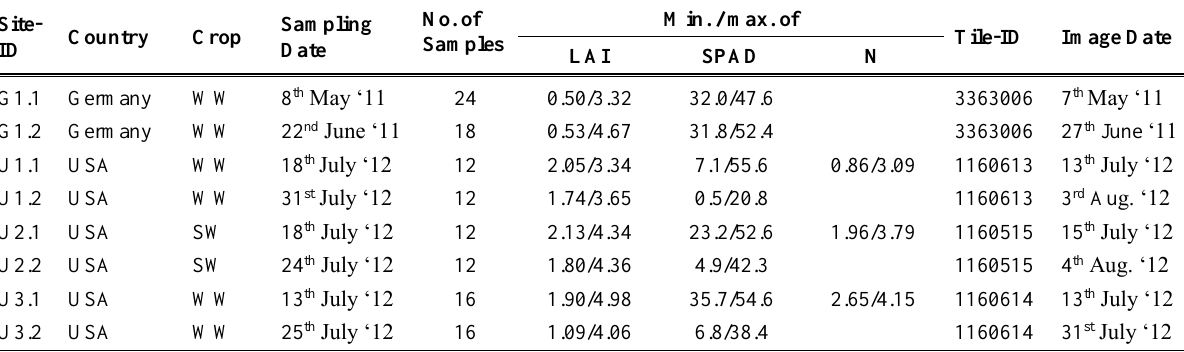
Table 1. Ground reference data of leaf area index (LAI), chlorophyll (SPAD) and nitrogen (N) concentration of winter (WW) and summer wheat (SW) and corresponding RapidEye imagery. Site-ID is coded according to country, field and date, e.g. G1.1